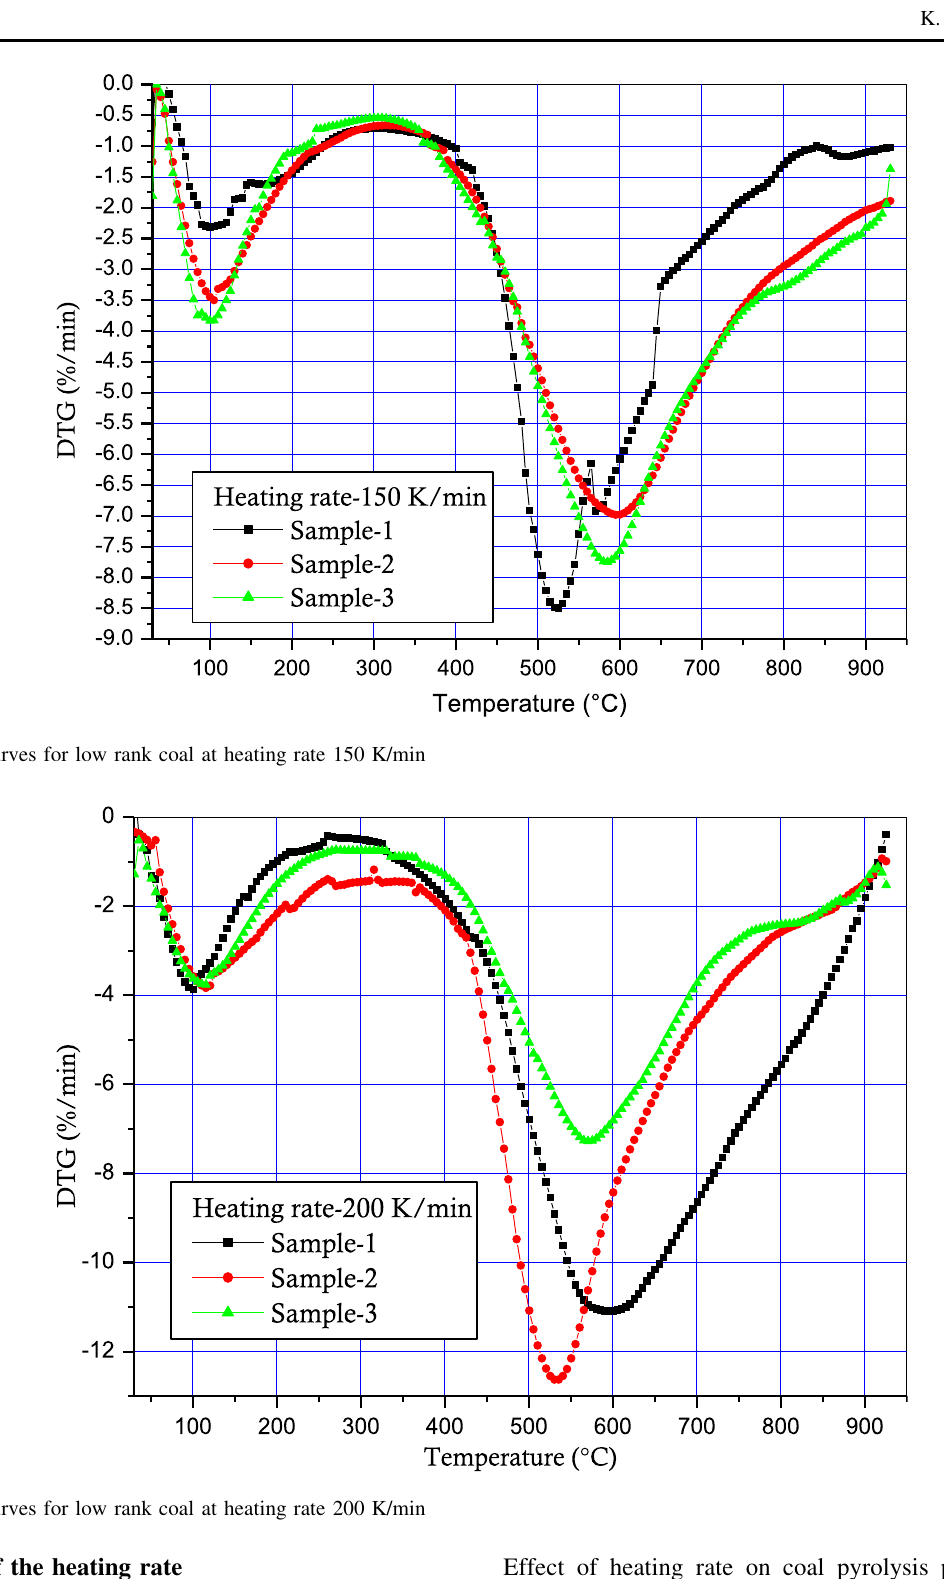
Fig. 8 DTG curves for low rank coal at heating rate 200